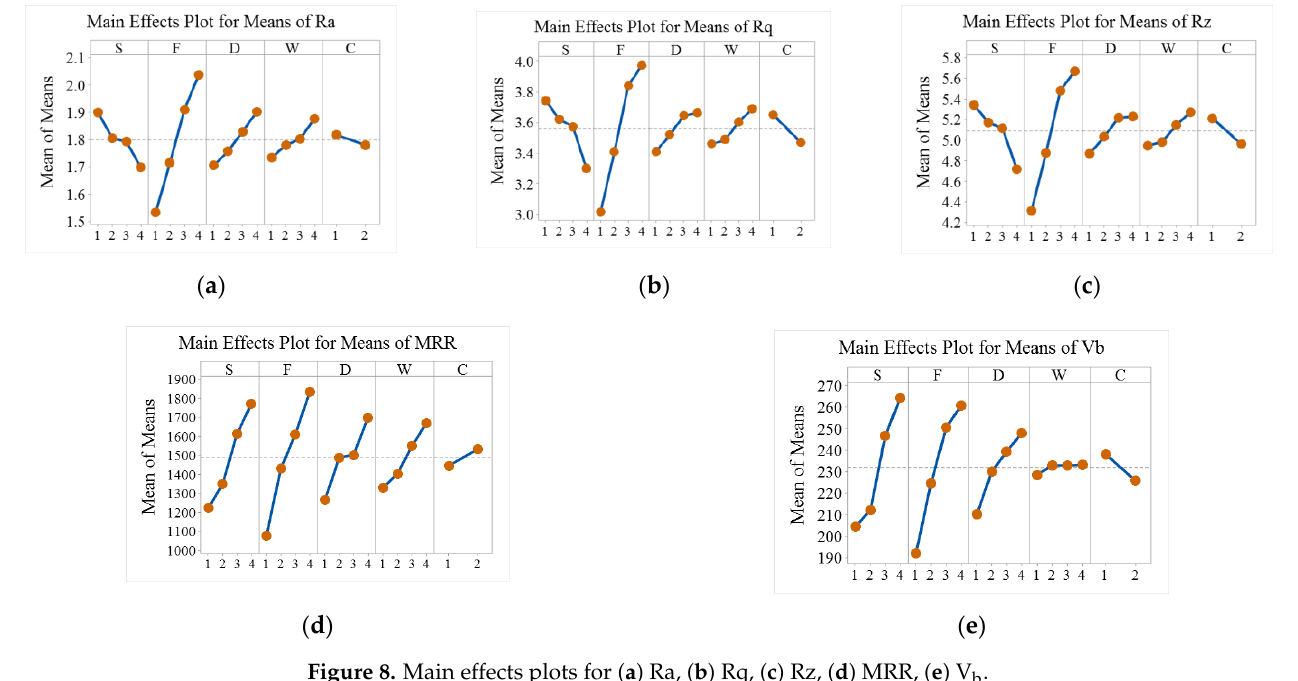
Figure 8. Main effects plots for ( a ) Ra, ( b ) Rq, ( c ) Rz, ( d ) MRR, ( e ) V b